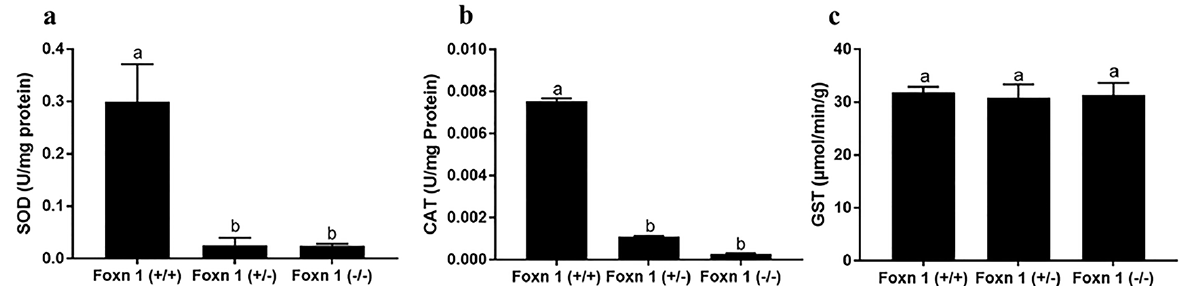
Figure 3. Oxidative stress analysis. a. Superoxide dismutase (SOD), b. Catalase (CAT), and c. Glutathione Transferase (GST) levels. Values as mean ± SD. Different letters (a,b,c) are statistically different ( P<0.05 )